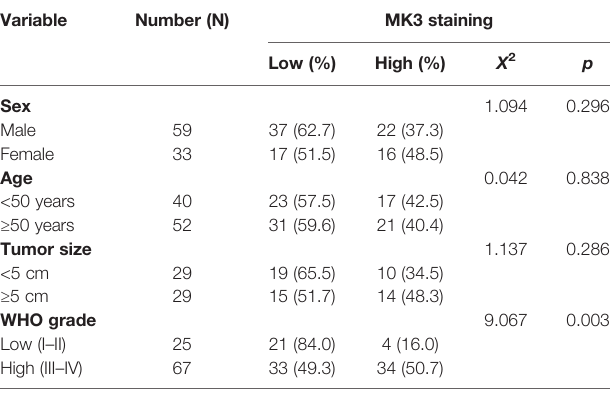
TABLE 1 | MK3 IHC staining and clinicopathologic characteristics of glioma patients.